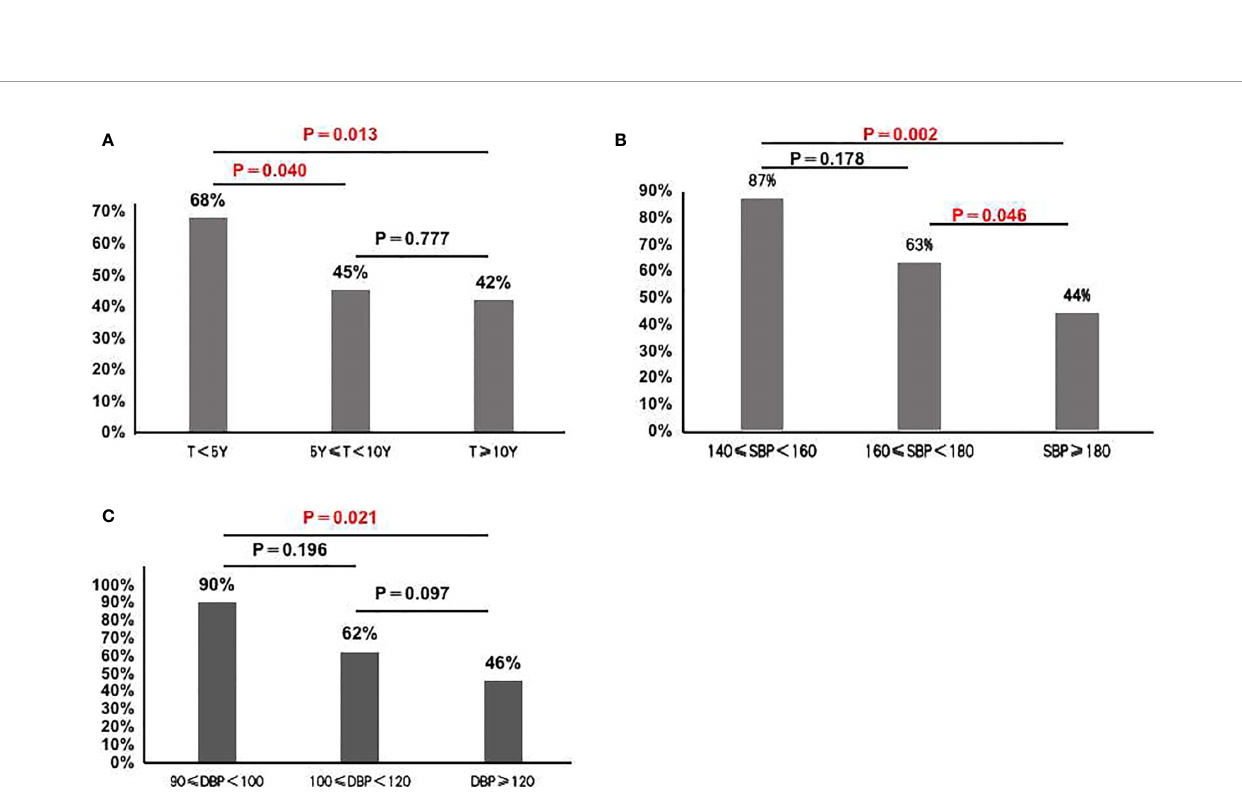
FIGURE 2 | (A) Cure rate of hypertension in the group with hypertension during less than 5 years, more than 5 years and 10 years (68% vs. 45% vs 42%); (B) Cure rate of hypertension in the group with SBP<160 mmHg group, 160 mmHg ≤ SBP<180 mmHg group and SBP ≥ 180 mmHg group (87% vs . 63% vs 44%); (C) Cure rate of hypertension in the group with DBP<100mmHg group, 100mmHg ≤ DBP < 120mmHg group and DBP ≥ 120mmHg group(90% vs . 62% vs . 46%).